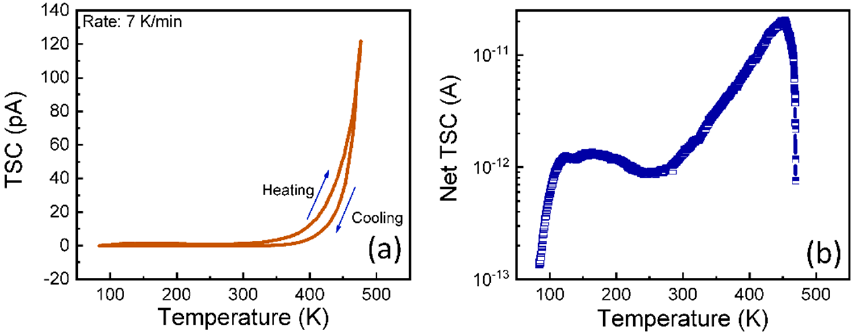
Figure 3. ( a ) Heating and cooling curve of TSC at 7 K/min heating rate, ( b ) net TSC spectrum of the β -Ga 2 O 3 thin film .